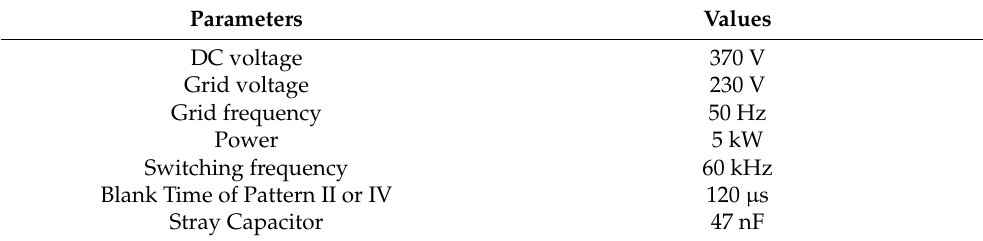
Table 1. Key parameters of hardware